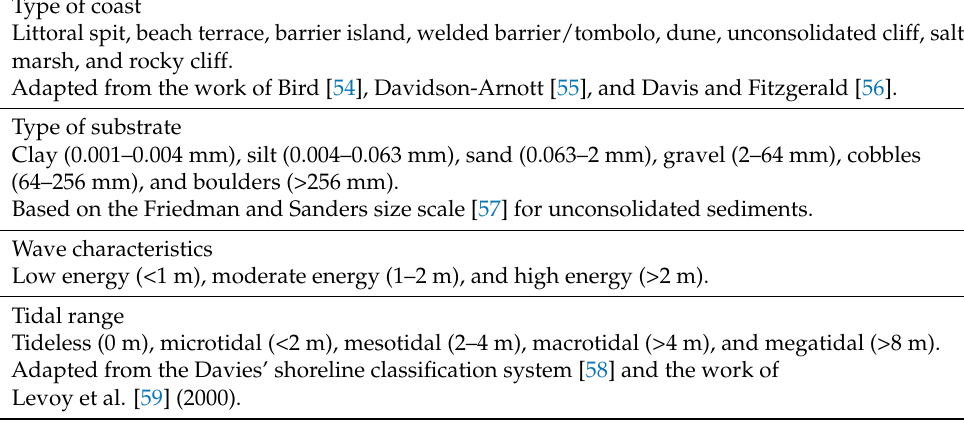
Table 3. Classification systems used to homogenize four types of study site environmental features, as described by the authors in scientific publications. These four types are used in the algorithm as base variables to evaluate CDMs according to different coastal